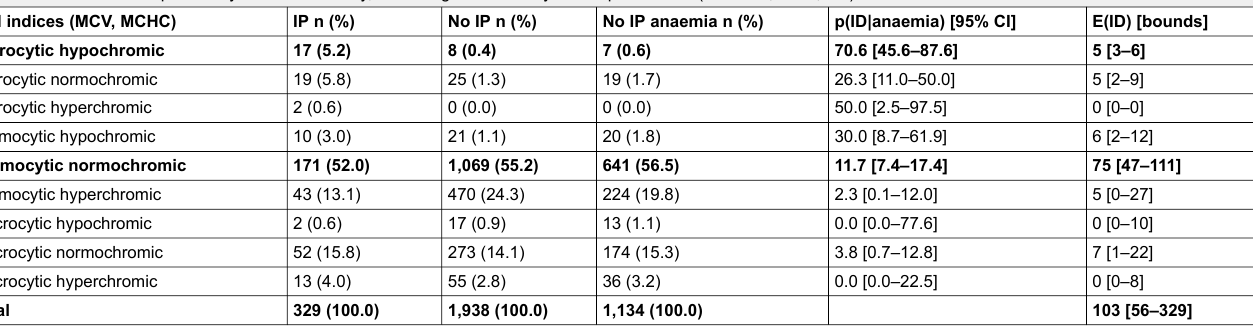
Table 5 : Cell indices and probability of iron deficiency, according to availability of iron parameters (all cases, n = 2,267). Cell indices (MCV, MCHC)